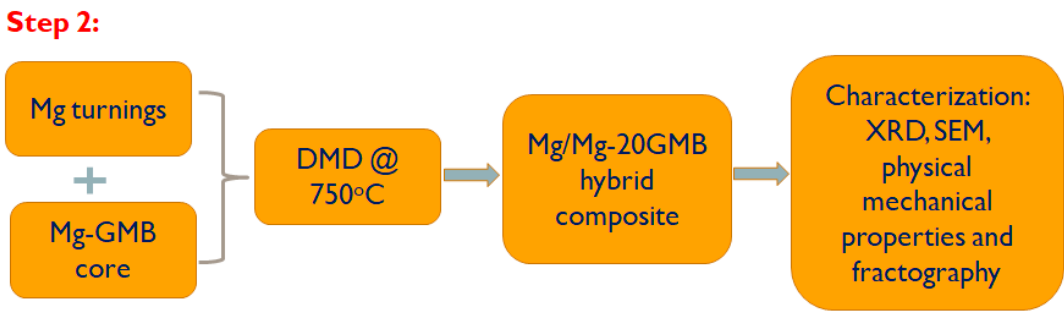
Figure 2. Schematic representation of the processing of Mg/Mg-20GMB hybrid composite.